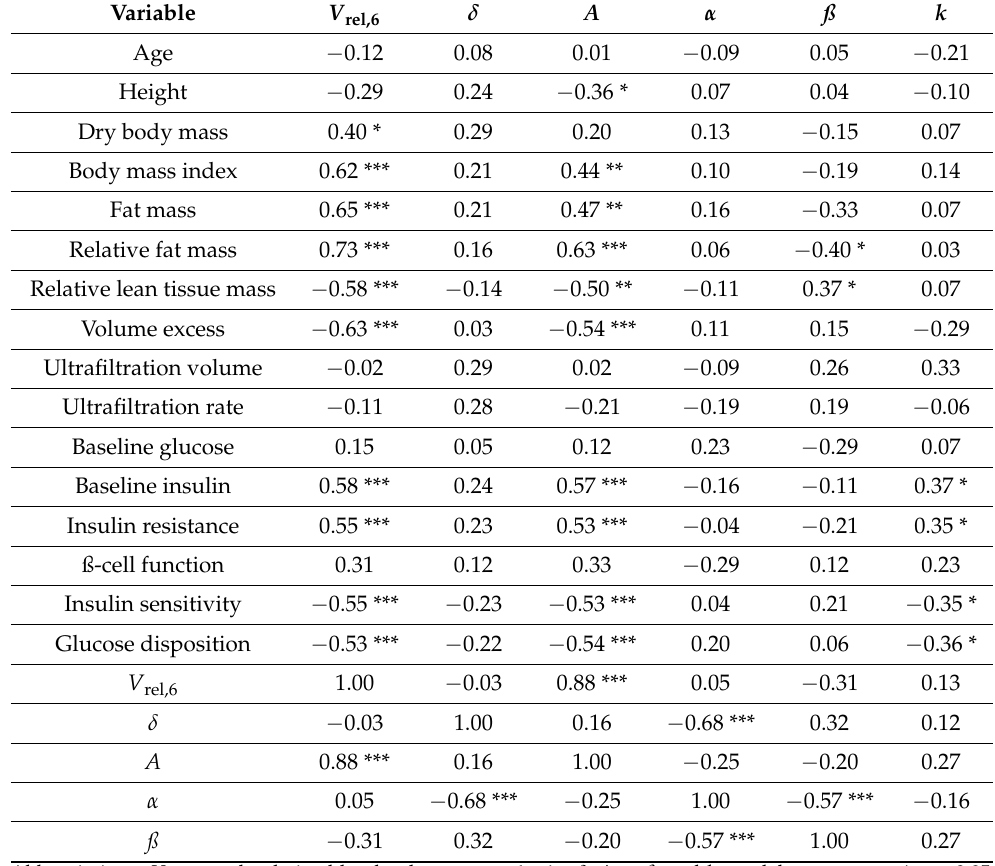
Table 3. Correlation coefficients of model